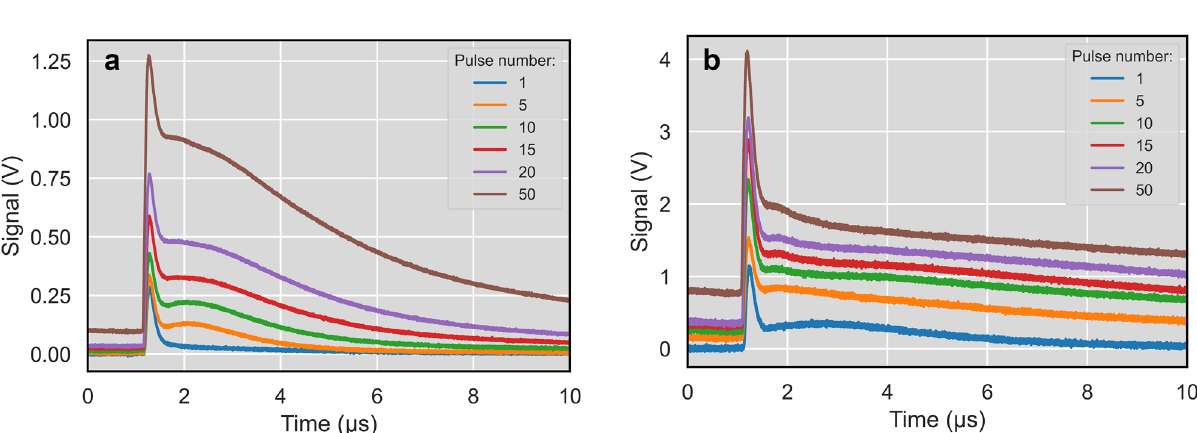
Figure 4. IR radiometry signal evolutions for different fluence and number of pulses: ( a ) 0.12 J/cm 2 , ( b ) 0.24 J/ cm 2